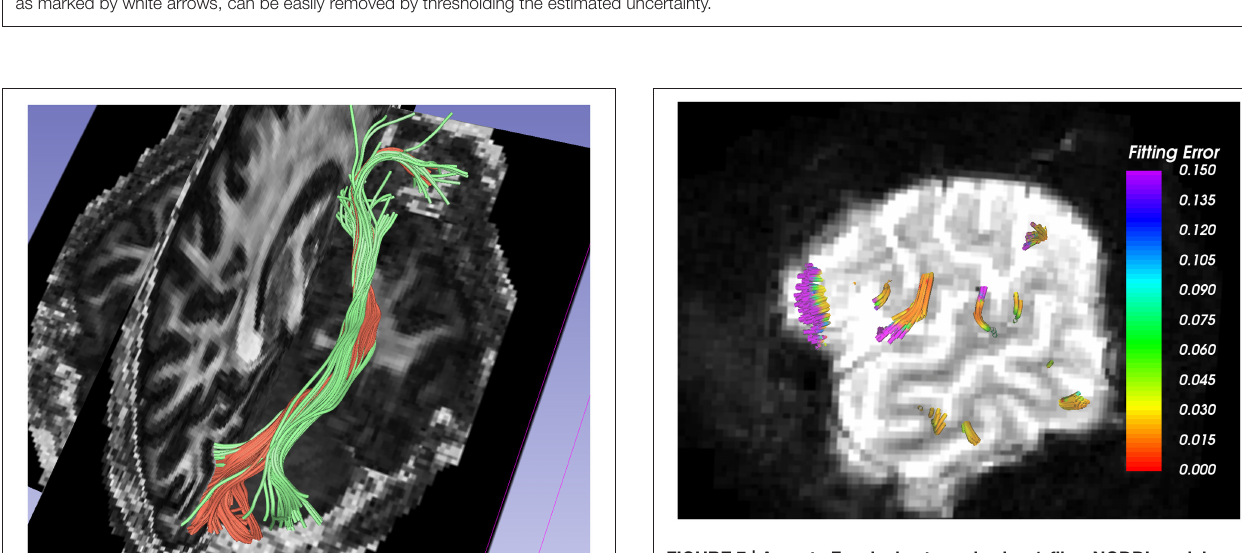
FIGURE 7 | Arcuate Fasciculus traced using 1-fiber NODDI model. Background is the b = 0 image, where very bright regions indicate CSF areas. As seen, higher error in data fitting occurs only in the CSF areas, which is extremely noisy with free isotropic